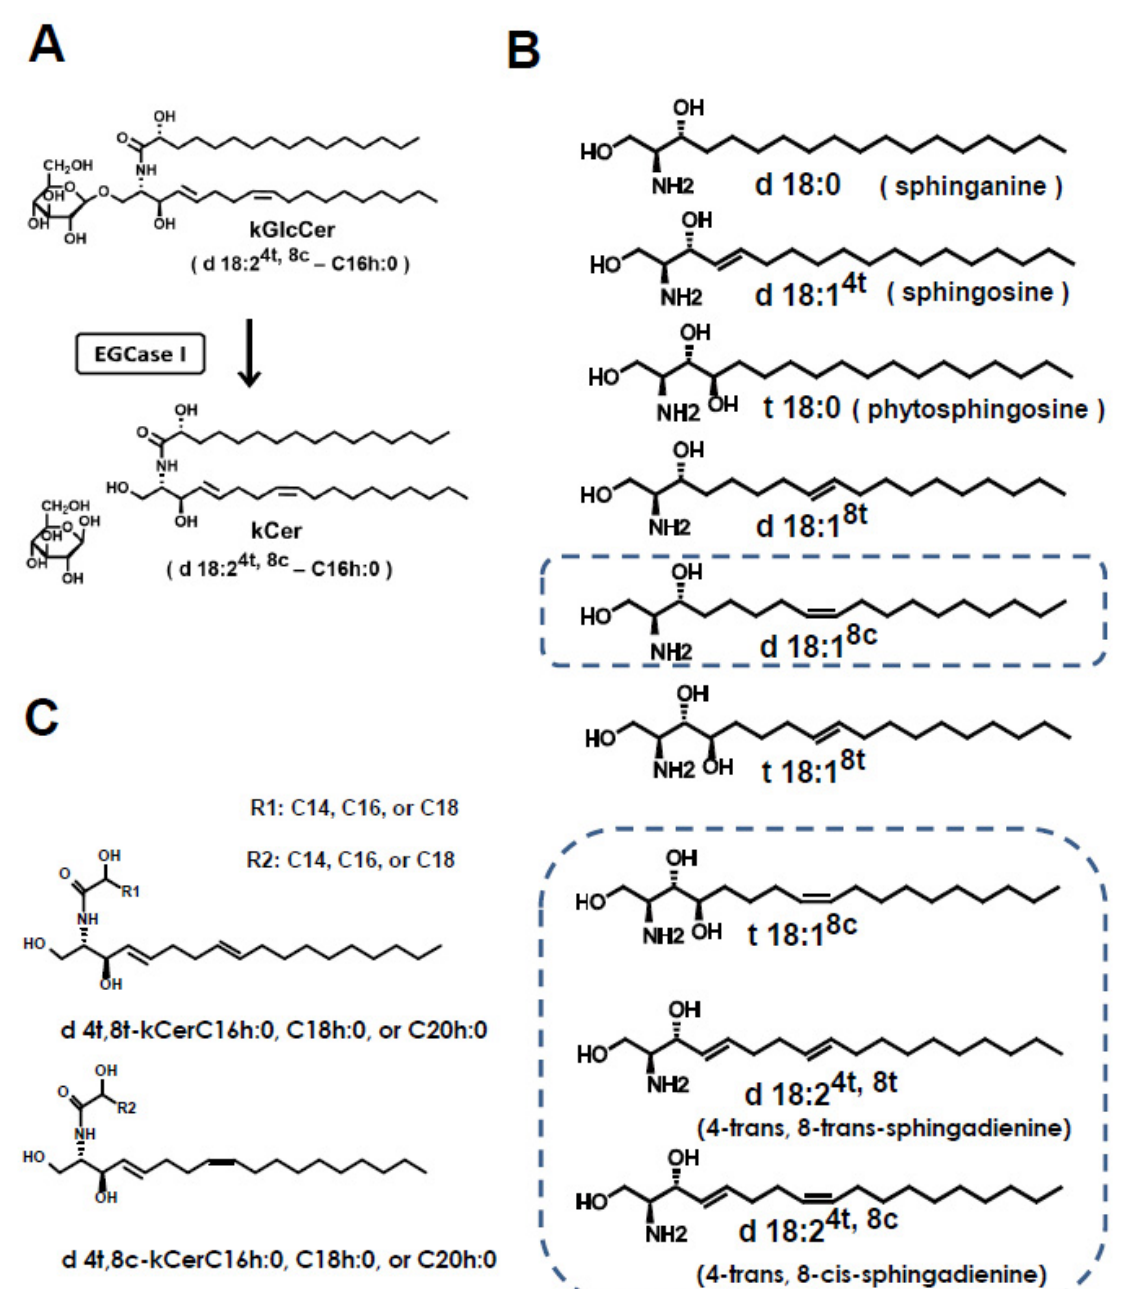
Figure 1. Chemical structure of ceramide species and EGCase I-catalyzed degucosylation for kCer preparation. ( A ) The EGCase reaction of kGlcCer. Plant-type ceramides can be prepared by treating plant-type GlcCer with EGCase I. A major molecular species of kCer (d18:2 4t,8c -C16h:0) is shown. ( B ) Primary long-chain bases found in plants. The long-chain bases included in konjac ceramide (kCer) produced by EGCase treatment are indicated by a dotted rectangle. ( C ) kCer molecular species generated by EGCase treatment of kGlcCer. The carbon chain length of each hydroxyl fatty acid (C14, C16 and C20) is shown in R1 and R2, respectively. Figure 1 is referred from [5], and used the copyright permission of the corresponding author. The nomenclature for long-chain bases and ceramides follows the recommendations of the IUPAC-IUBMB Joint